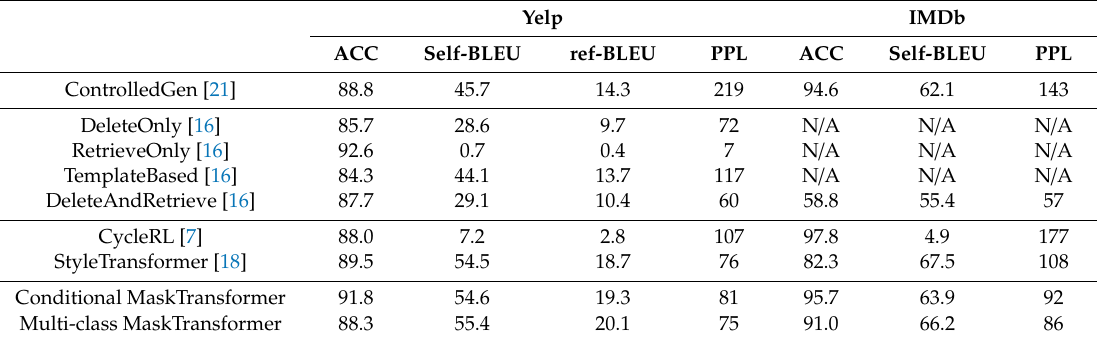
Table 2. The automatic evaluation results of the Yelp and IMDb datasets.